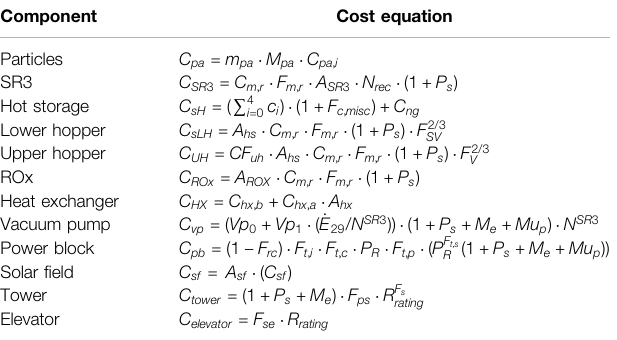
TABLE 5 | Scaling equations for equipment